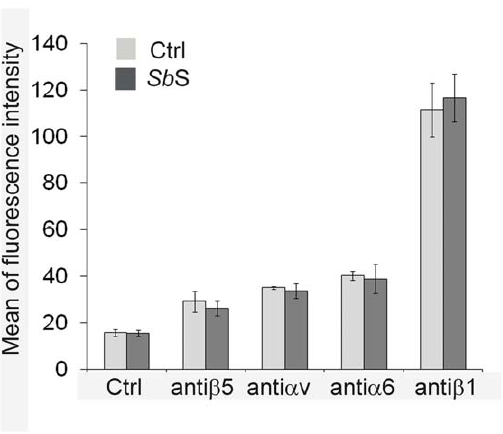
Figure 5. Impact of Sb S on integrin expression. Sub-confluent HCT-8/E11 cells were incubated for 5 h with (dark bars) or without (light bars) Sb S, then harvested and resuspended in the presence of anti- integrin subunit mAbs. After incubation with the appropriate secondary Alexa 488-conjugated Ab, cell-bound fluorescence was quantified using a Becton-Dickinson FACScan flow cytometer. Non-specific labeling was determined by incubating cells with the secondary Alexa 488- conjugated Ab alone (Ctrl). Data represent the mean + SD of 6 separate experiments.